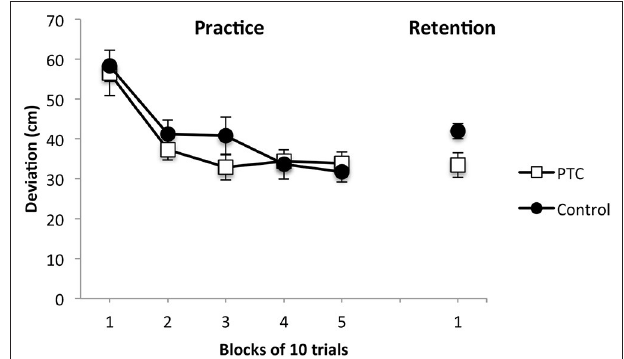
FIGURE 1 | Putting performance (i.e., deviation from the center of the target) of the positive temporal-comparison and control groups during practice and retention. Error bars indicate standard